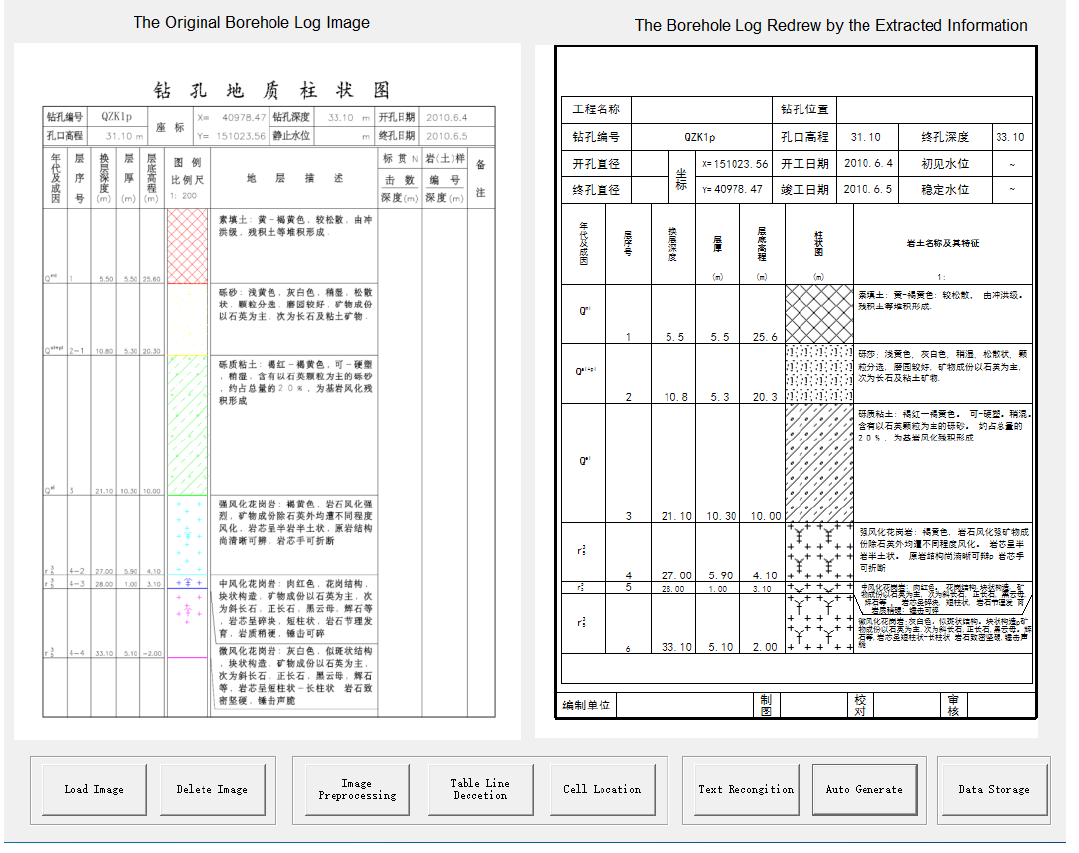
Figure 15 Figure 15. The interface of the automatic borehole log information extraction